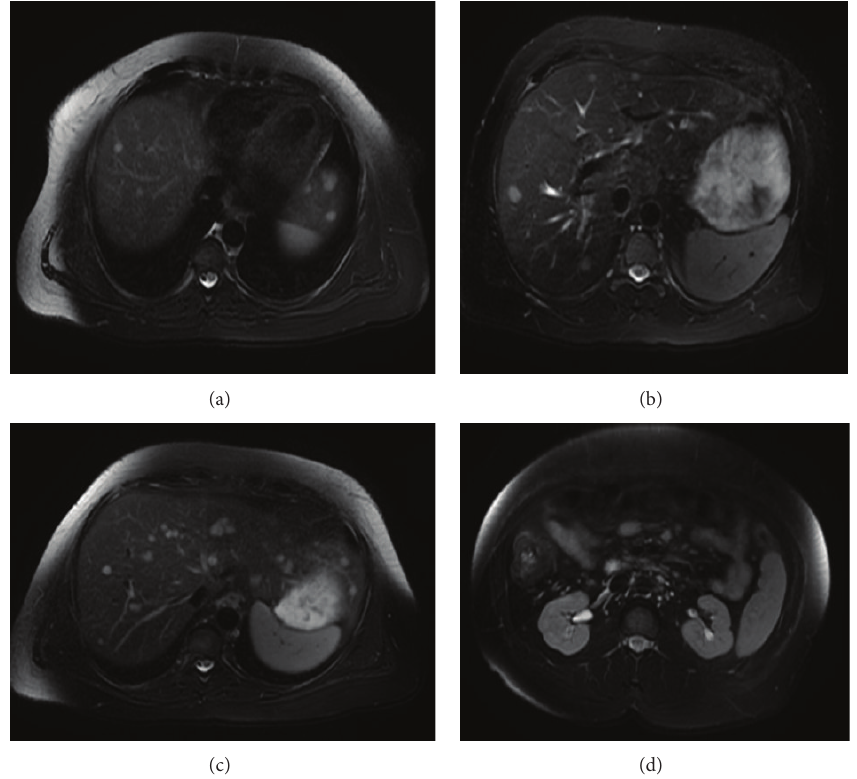
Figure 7: Numerous hepatic lesions seen, with the largest lesion at the dome of the lateral segment of left lobe of liver measuring 2.1 × 1.4 cm; multiple enlarged lymph nodes in small bowel mesentery and porta hepatis also